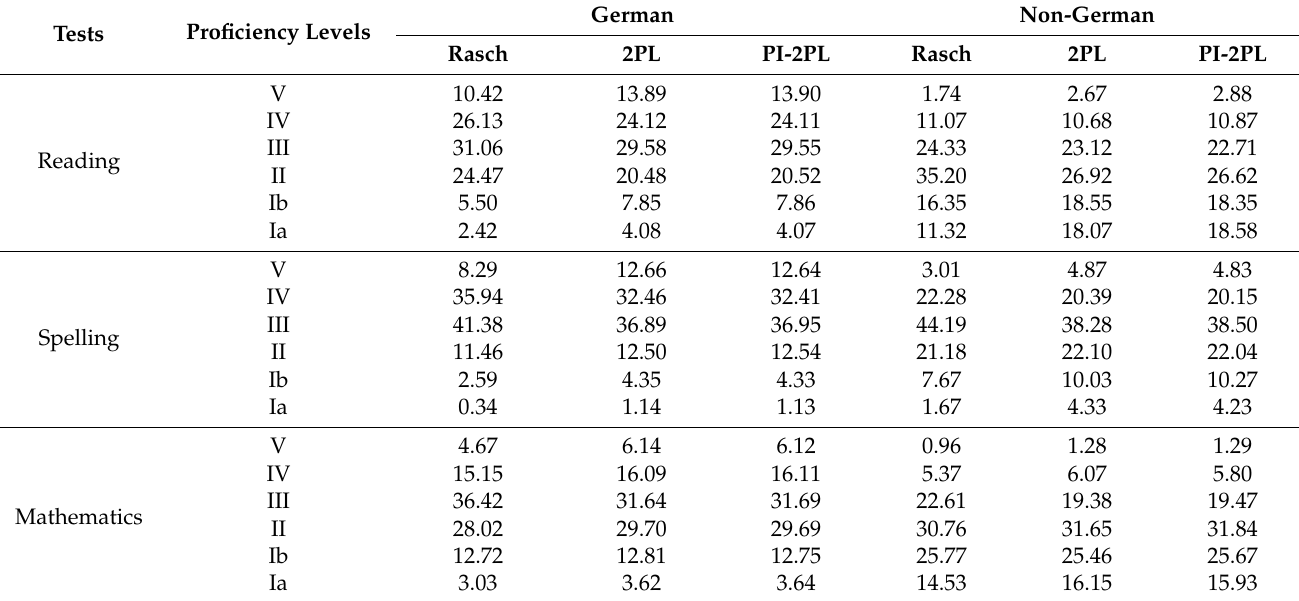
Table 8. Proportion (%) of students at each proficiency level, by language